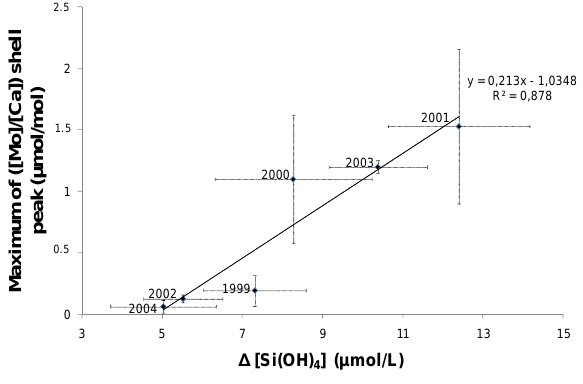
Figure 6. Relationship between maximum intensity of spring ([Mo]/[Ca]) shell peak (µmol/mol) and the difference of average silicic acid concentration (µmol/L) between winter (January and February) and spring (May and June), i.e. a delta silicic concentration. The error bars represent the standard deviations on the average ([Mo]/[Ca]) shell maximum and on the average ∆ [Si(OH) 4 ].